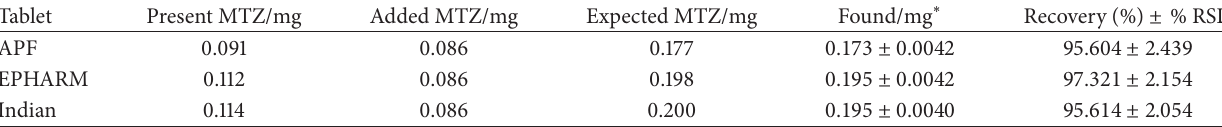
Table 2: Percentage recovery of MTZ from pharmaceutical tablets.